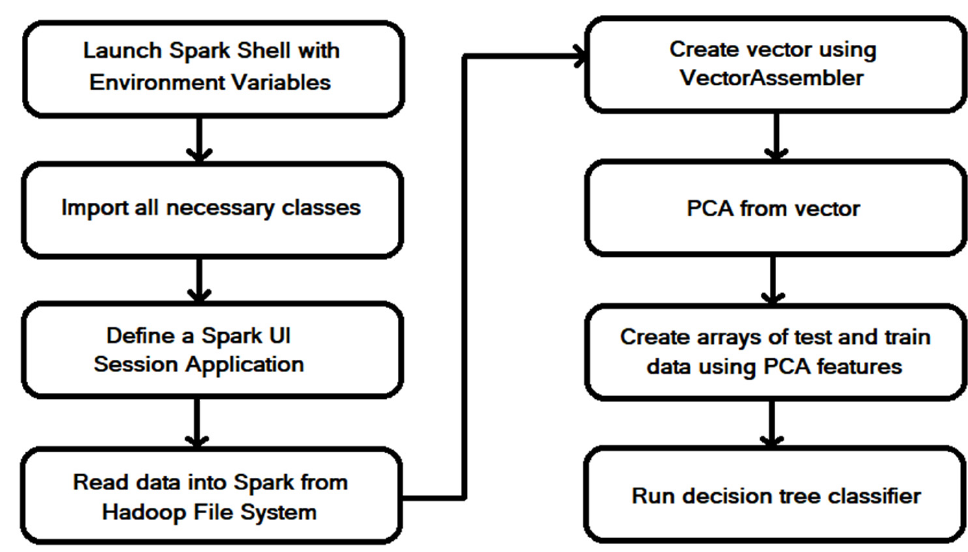
Figure 3. Flow Diagram for Methodology.